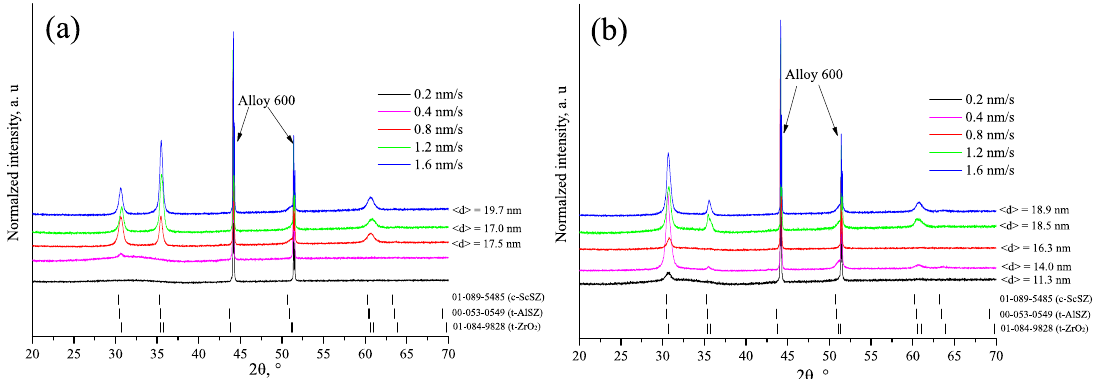
Figure 4. XRD patterns (measured at room temperature) of 6ScAlSZ thin films deposited on Alloy 600 substrates using ( a ) 300 °C and ( b ) 600 °C substrate temperatures and different deposition rates from 0.2 to 1.6 nm/s.